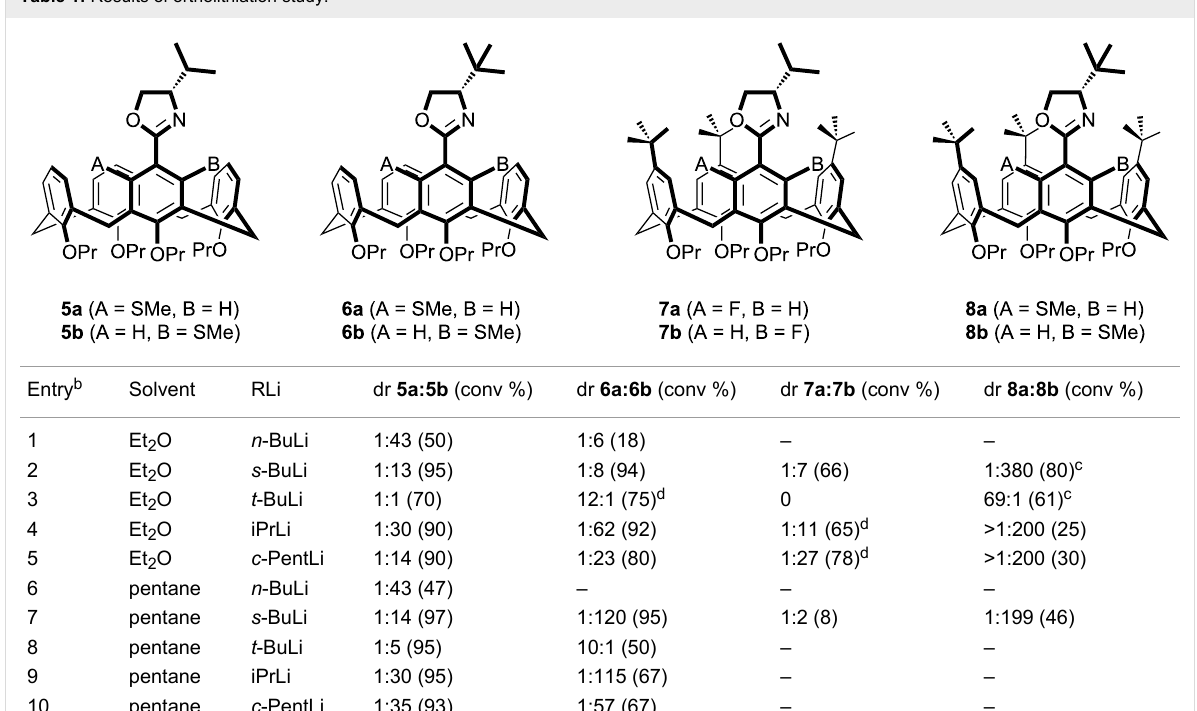
Table 1: Results of ortholithiation study. a